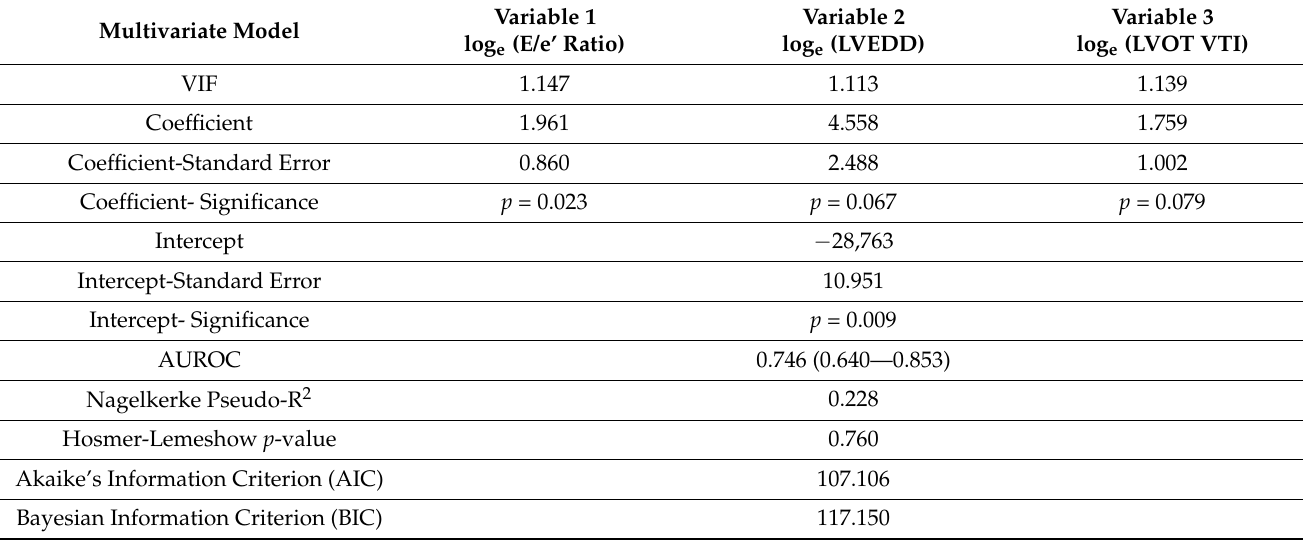
Table 4. Multivariate Model Information- statistical characteristics of model